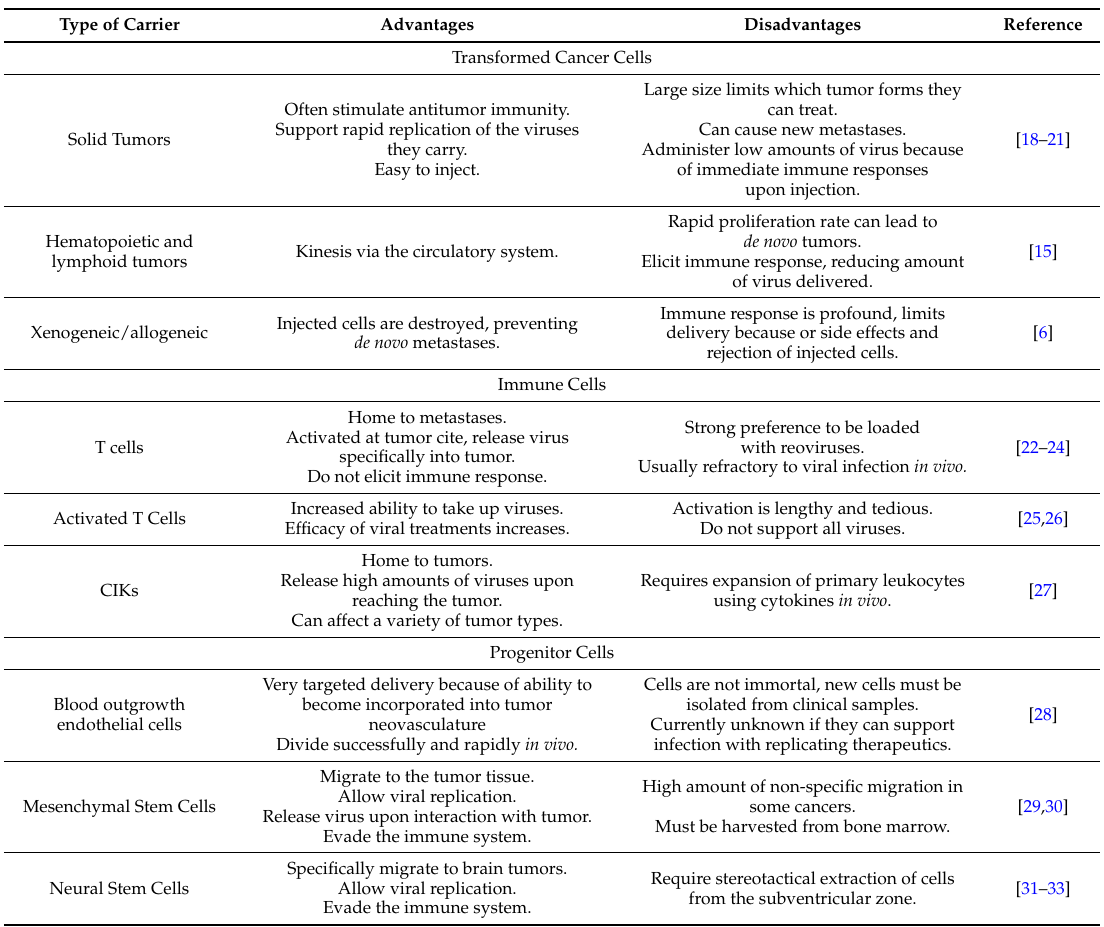
Table 1. Examination of cell lineages used as carriers for delivery of oncolytic viruses to malignancies. Advantages and disadvantages of each type of carrier are indexed, with citations of preclinical studies investigating these carriers listed